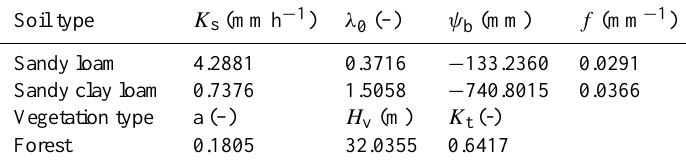
Table 2. Model calibrated parameters for the period 1 January 1991 to 31 December 2010 at the Tonto Creek basin. Parameters for soil are saturated hydraulic conductivity ( K s ) and its decay exponent with depth ( f ), pore-size distribution index ( λ 0 ) and air entry bubbling pressure ( ψ b ) and for vegetation, albedo (a), vegetation height ( H v ) and optical transmission coefficient ( K t